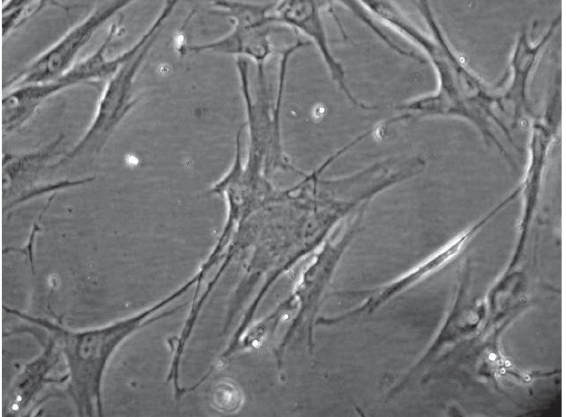
Fig. 1. Differentiation of BMSC-AS cells to osteogenic